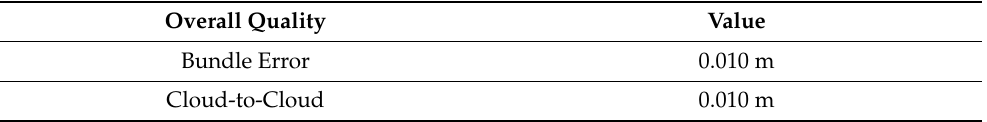
Table 5. The accuracy of TLS point clouds alignment.